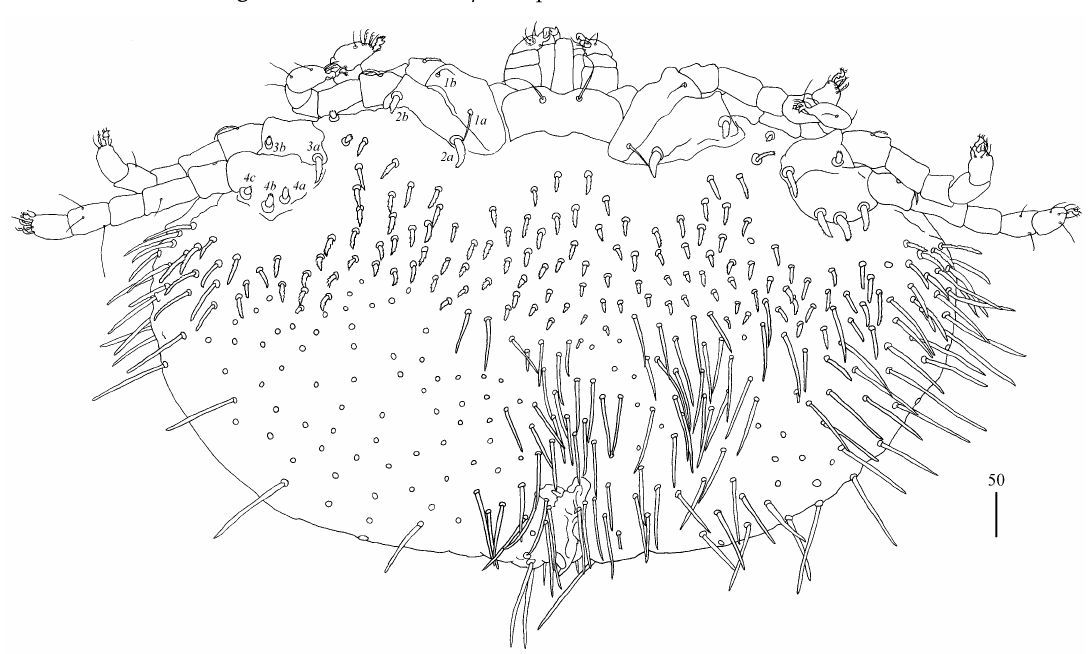
Figure 15. Geckobia brevicephala sp. n. female in ventral view.